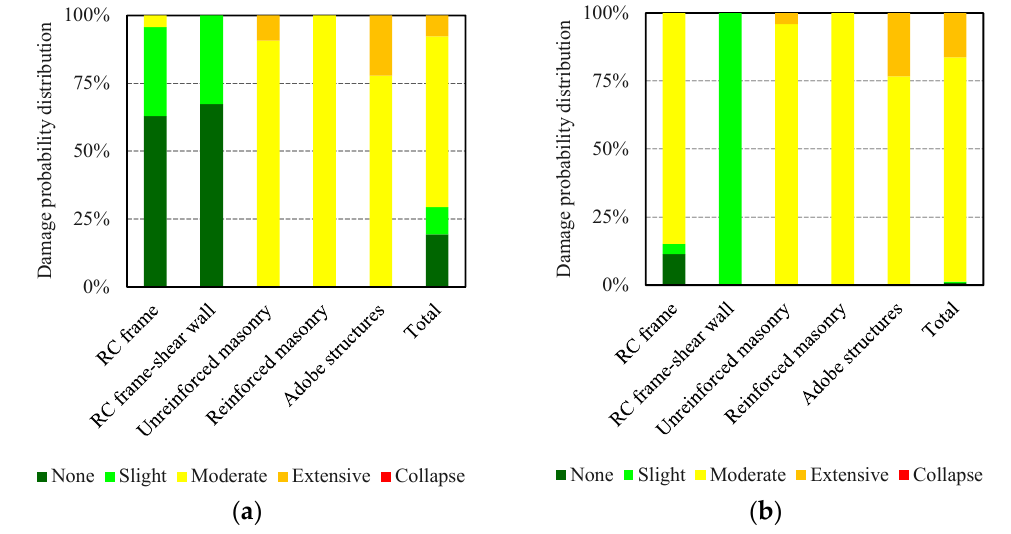
Figure 10. Seismic results of a ( a ) typical town and ( b ) country in the Aba region subjected the ground motion from the Jiuzhaigou Baihe station.